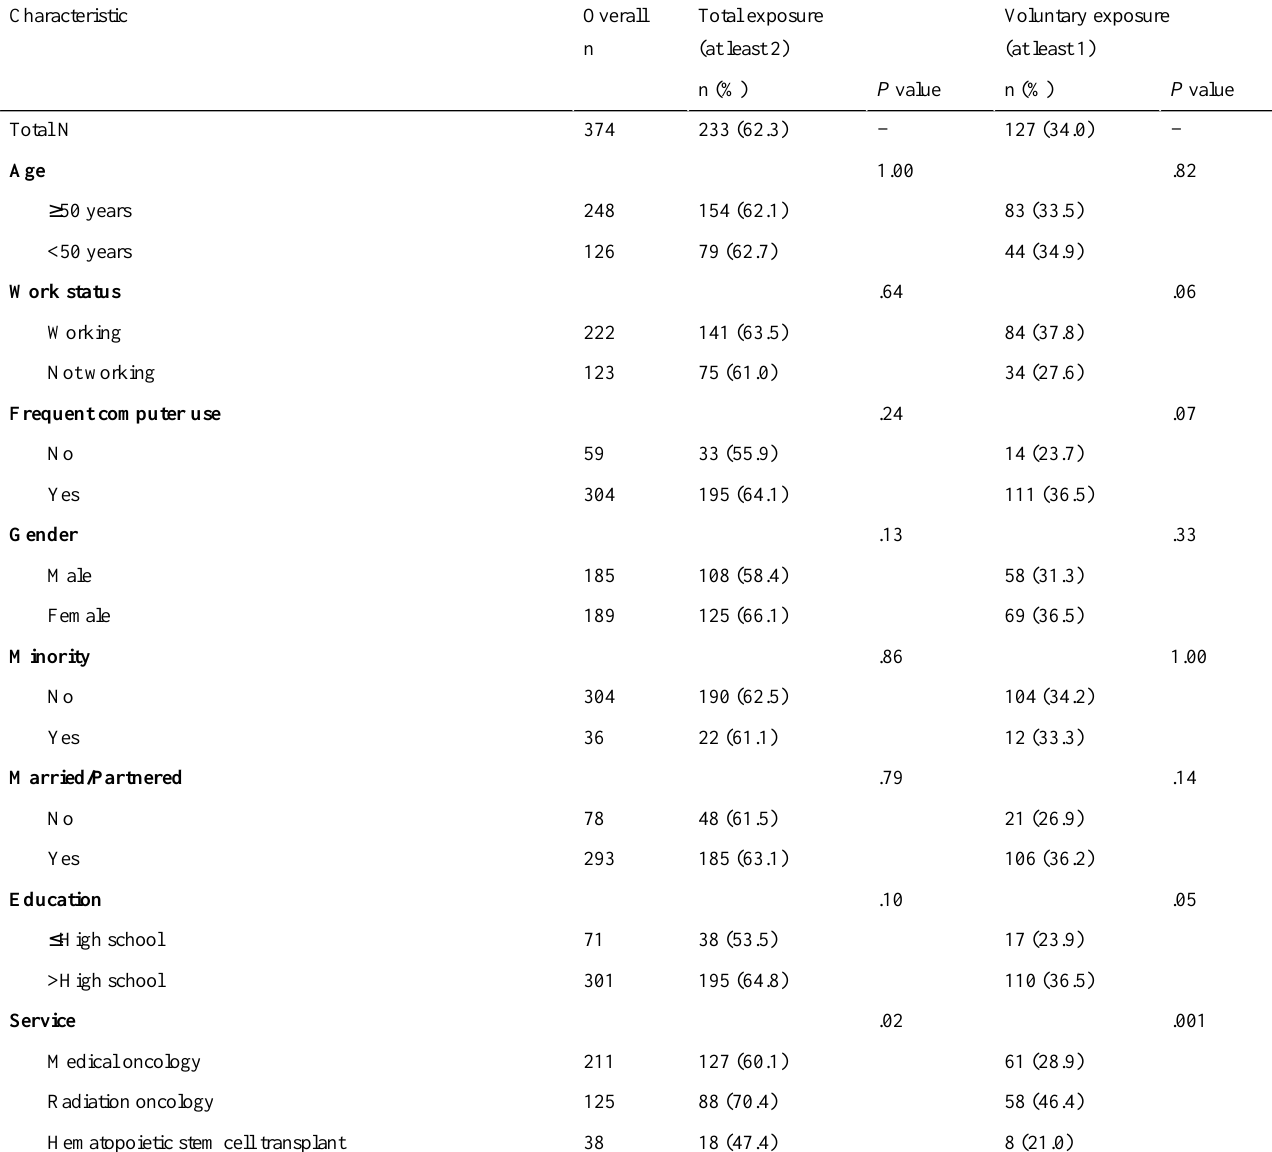
Table 1. Number and frequency of total exposures and voluntary exposures by selected participant characteristic.